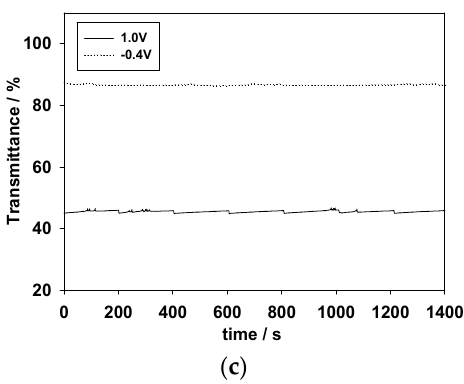
Figure 11. Open circuit stability of ( a ) PMPS/PProDOT-Et 2 ECD monitored at 590 nm; ( b ) PMPO/PProDOT-Et 2 ECD monitored at 626 nm; and ( c ) PANIL/PProDOT-Et 2 ECD monitored at 628 nm.